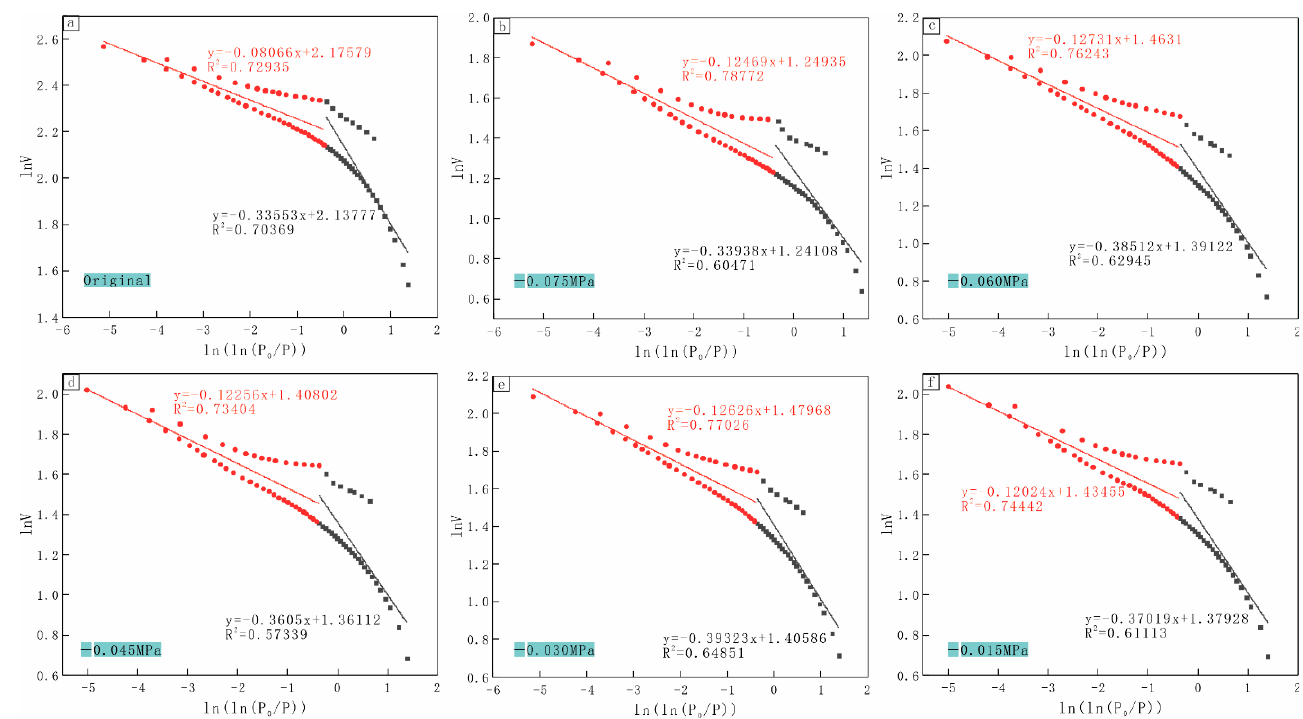
Figure 6. ( a – f ) Double logarithm curves of the low-temperature nitrogen adsorption volume and relative pressure of the low-rank coal samples from the study area under different negative pressure conditions. Table 4. Calculation results of the fractal dimensions of the adsorption pores based on the FHH fractal